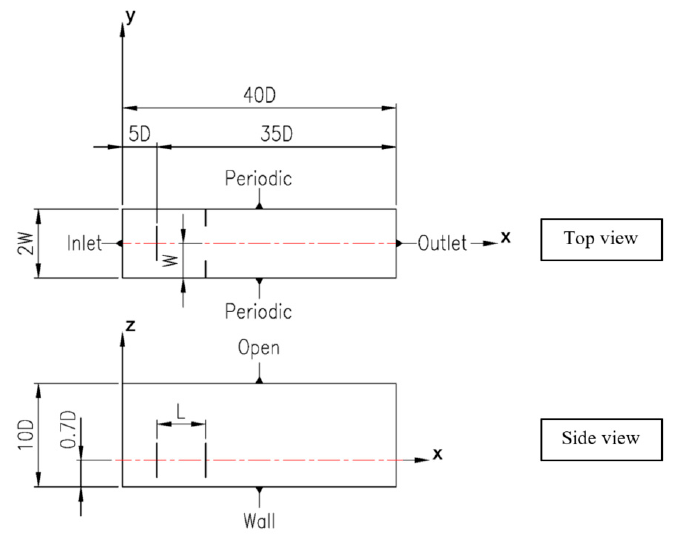
Figure 8. Computational domain of the two-low staggered model.